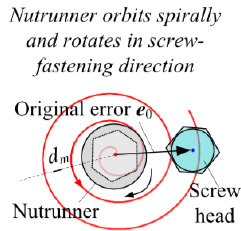
Figure 7. The spiral-motion-based screw–tool engagement